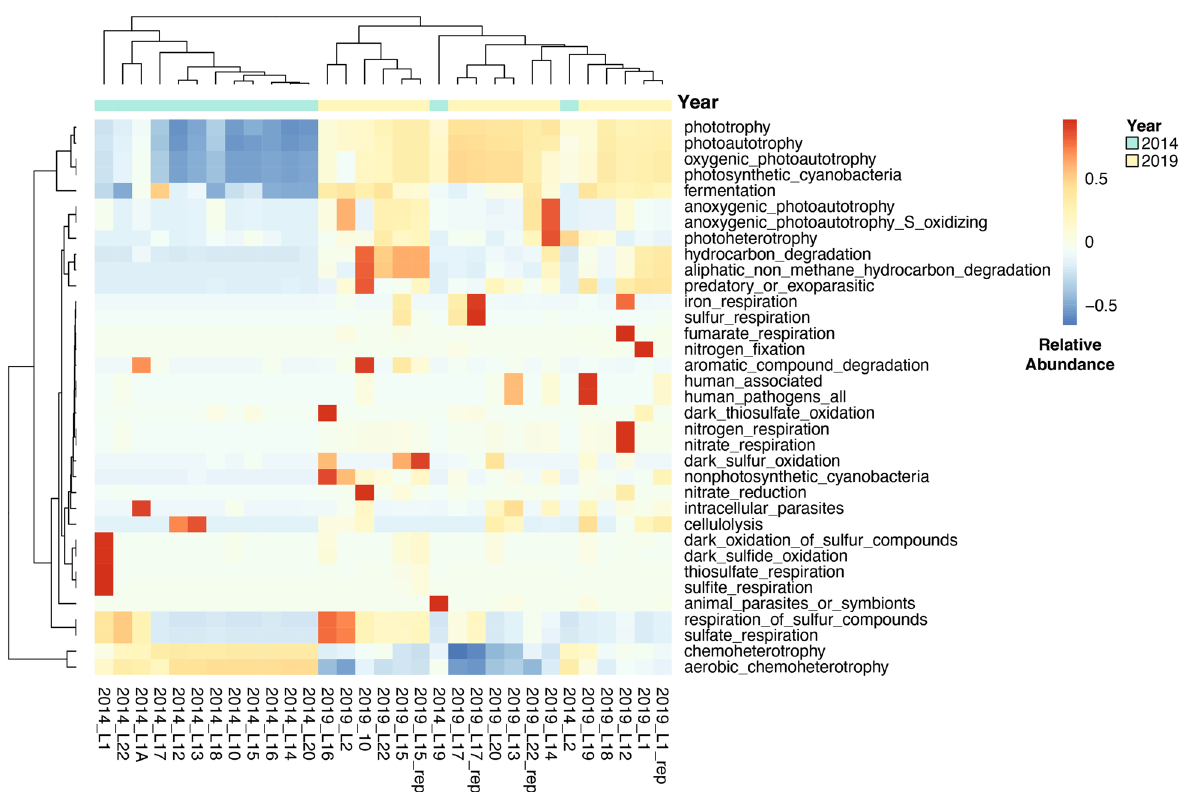
Figure 5. Heatmap showing relative abundances of metabolisms retrieved from Functional Annotation of Prokaryotic Taxa (FAPROTAX) for each sample. For each metabolism (rows), the relative abundances of each sample are centered, standardized and scaled to [− 1, 1] interval. For rows (metabolisms) and columns (lake samples), dendrograms from hierarchical clustering using the distance and clustering methods distfun and hclustfun are made and shown in the figure. All analyses were performed using R Statistical Software (v4.1.3; R Core Team 2022, https:// www.R- proje ct.